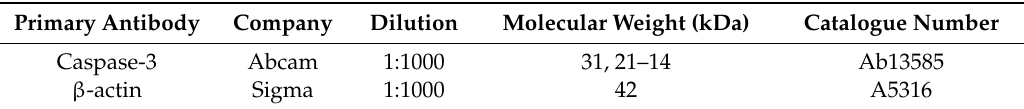
Table 3. Antibodies applied for Western blot